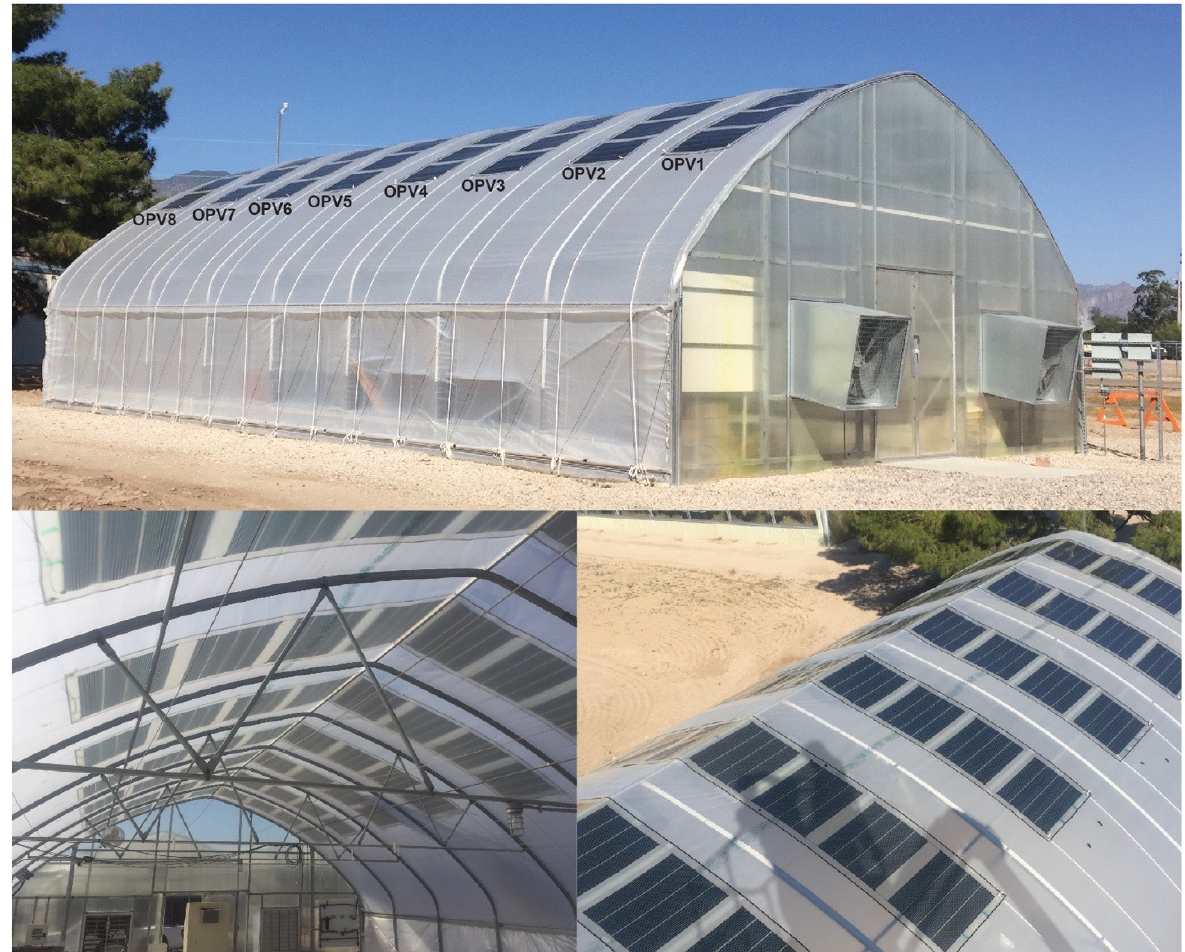
Figure 3. Eight OPV arrays ( labeled in top image ) installed on a gothic-arch style greenhouse roof; interior view of greenhouse roof with installed OPV arrays ( lower left ), and aerial view ( lower right ).